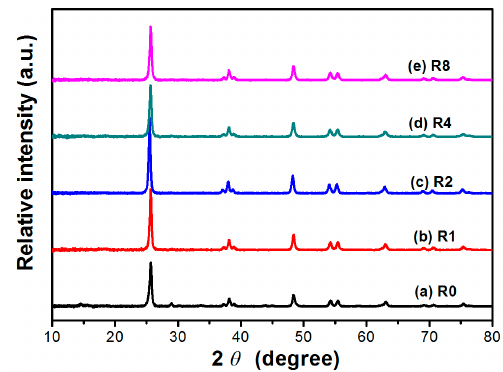
Figure 1. XRD patterns of TiO 2 nanorods prepared in the presence of different R (weight ratio of thiourea to TiO 2 ).